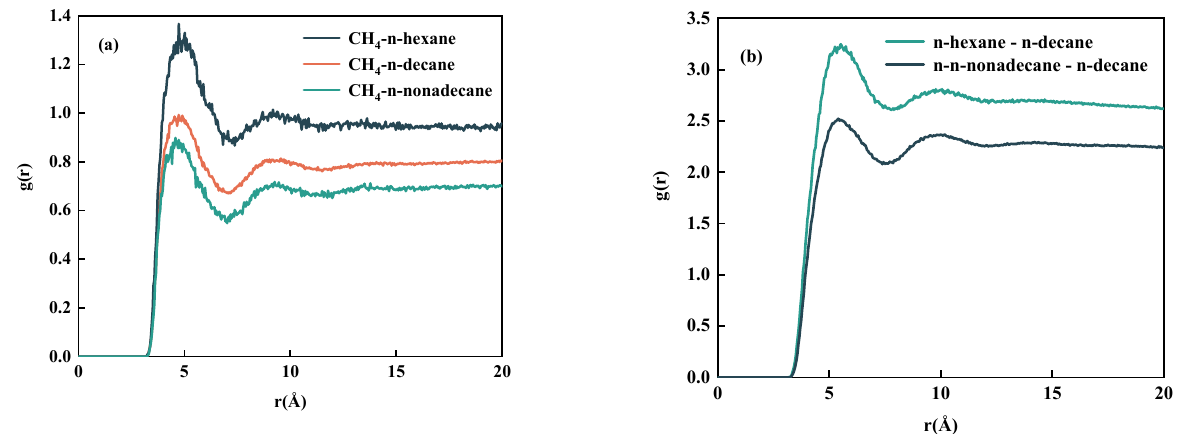
Figure 13. Radial distribution function of different component systems at 313.3 K, 5.2 MPa. ( a ) CH 4 - n-hexane, CH 4 -n-decane, CH 4 -n-nonadecane; ( b ) n-decane-n-hexane, n-decane-n-nonadecane.